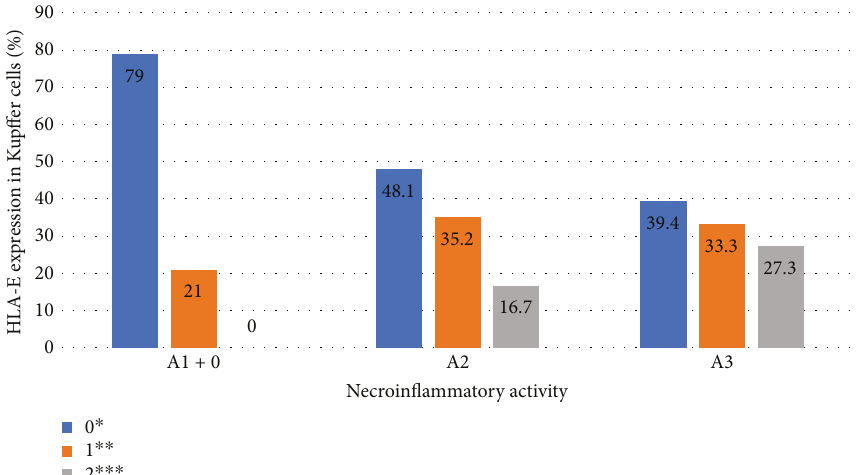
Figure 5: Association between HLA-E expression in Kup ff er cells and liver necroin fl ammatory activity. HLA-E expression was described in the following grades: 0 ∗ (without positive cell expression), 1+ ∗∗ ( < 25%), 2+ ∗∗∗ (25 – 50%). There was no grade 3+ expression in this case. Necroin fl ammatory activity was described according to the METAVIR classi fi cation: A0 +1: no or mild activity, A2: moderate activity, A3: severe activity. P = 0 002